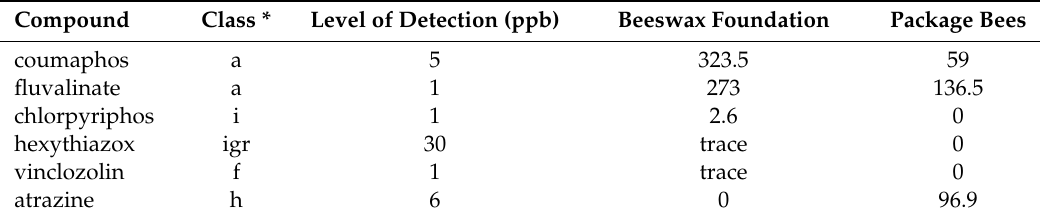
Table 4. Compounds detected in initial samples of package bees and foundation wax used to establish colonies in 2014. Results reported as ppb, and are a mean of two separate samples randomly taken on the day of